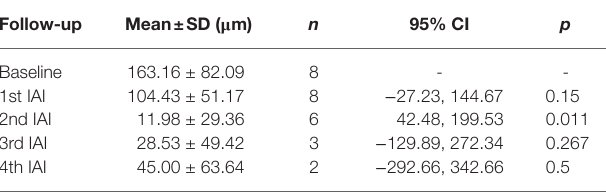
TABLE 4 | SRF before and after IAI in patients with